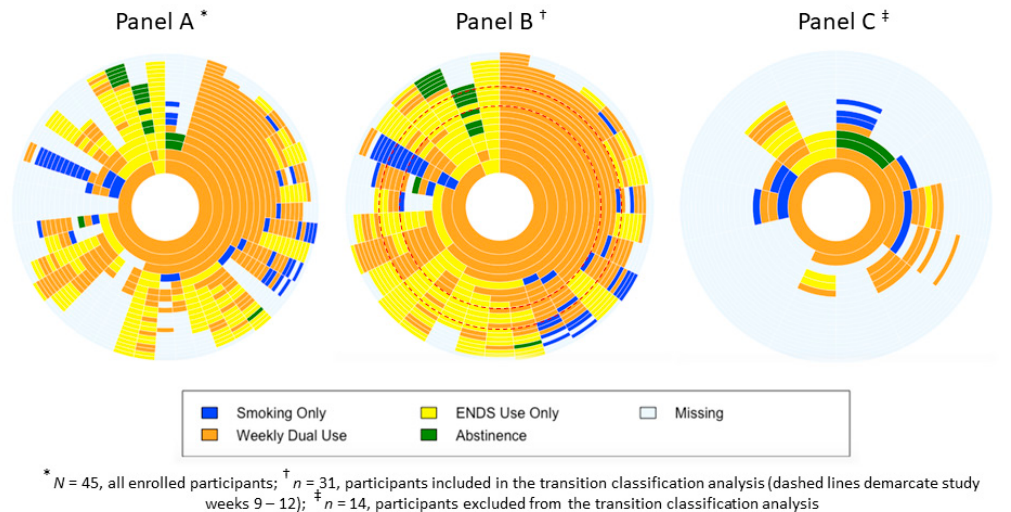
Figure 1. Sunburst plots of smoking and ENDS usage by weeks. The sunburst plots presented here are similar to pie charts, with the added dimension of time. Each “ring” represents a “study week” (the innermost ring represents study week 1) and summarises the proportion of participants according to the classification categories (smoking only, ENDS use only, weekly dual use, abstinent, missing data) for that specific week. The plots allow us to visualise the complexity of the transition process and the difficulty in assigning transition “outcomes” during an inherently unstable, non- linear